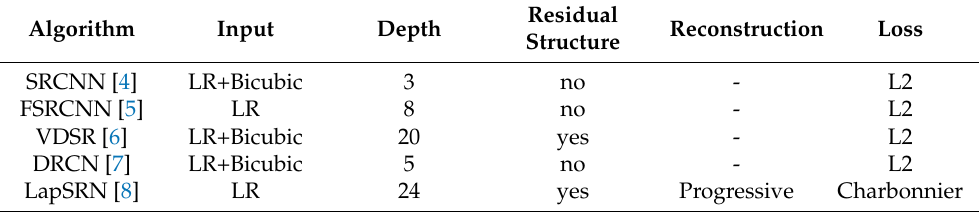
Table 2. Structural analysis of SRCNN [4], FSRCNN [5], VDSR [6], DRCN [7], LapSRN [8], RCAN [9].